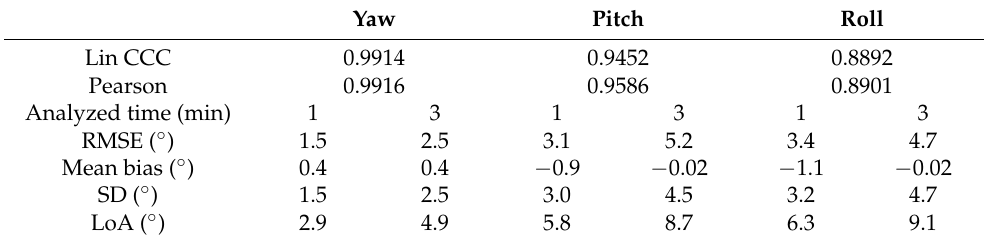
Figure 4. Comparison of IMU-based system and video system data for participant 1. Yaw angle ( a ), pitch angle ( b ), and roll angle ( c ). Table 3. Correlation coefficients, RMSE, and BAA parameters of the inertial angles for the 5-min